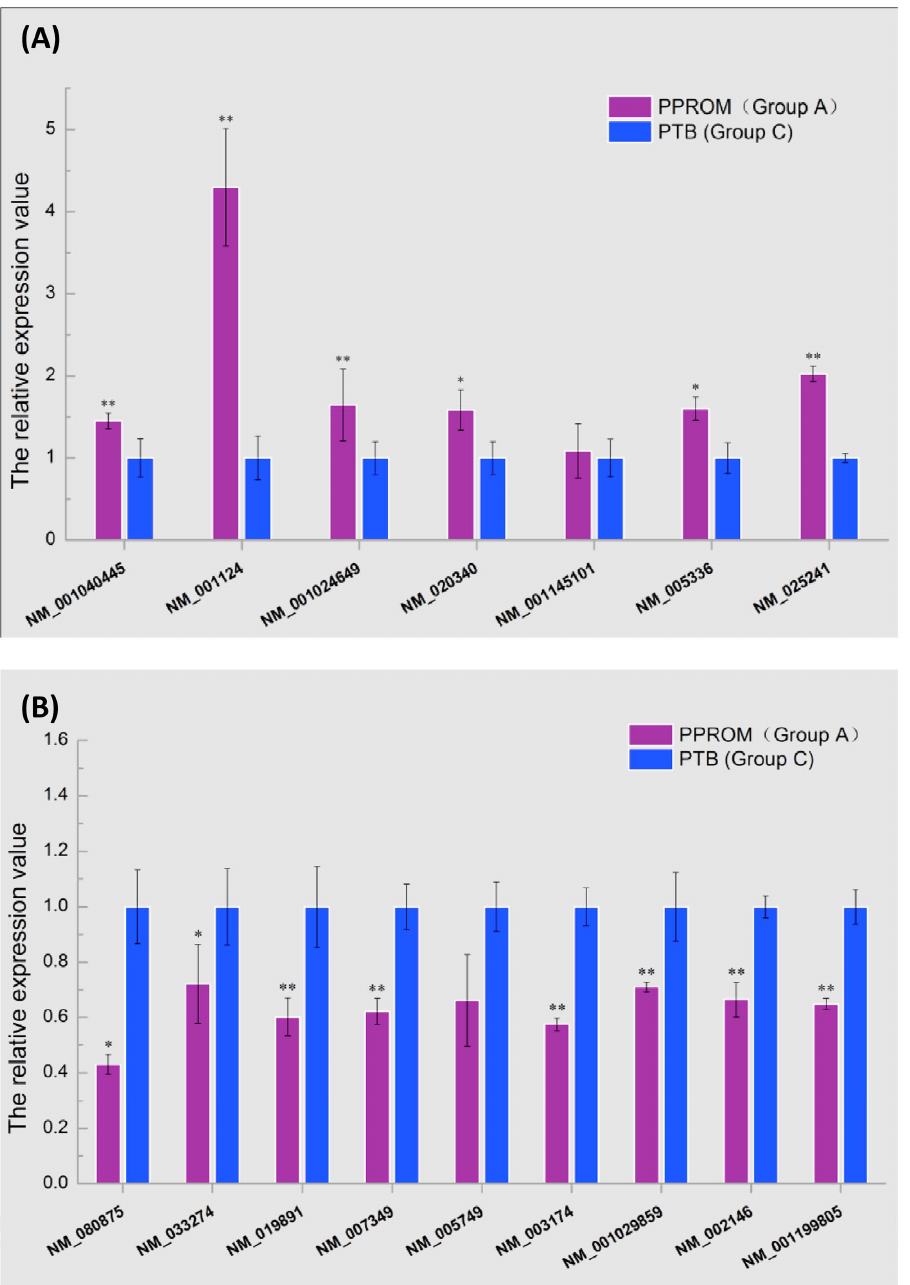
Figure 2. Validation of lncRNAs. RT-qPCR was applied to validate differentially expressed lncRNAs between the PPROM and PTB. Seven up- regulated lncRNAs (A) and nine down-regulated ones (B) were analyzed. Other than the sequence name, each lncRNA was labeled with its associated gene accession in GenBank for a purpose of easy access to its associated gene. Significant levels were indicated by * ( p , 0.05) and ** ( p , 0.01).